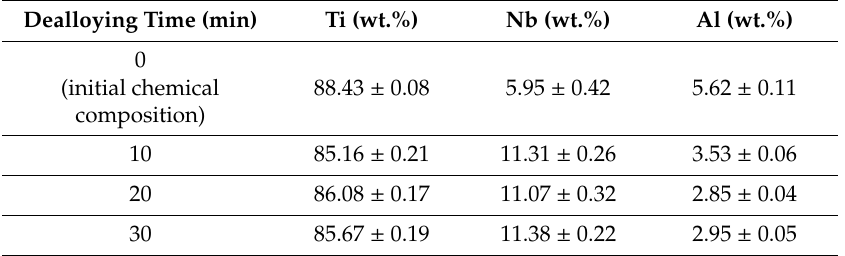
Table 1. Chemical composition of the surface before and after dealloying (porous layer) at 1150 K. Dealloying Time